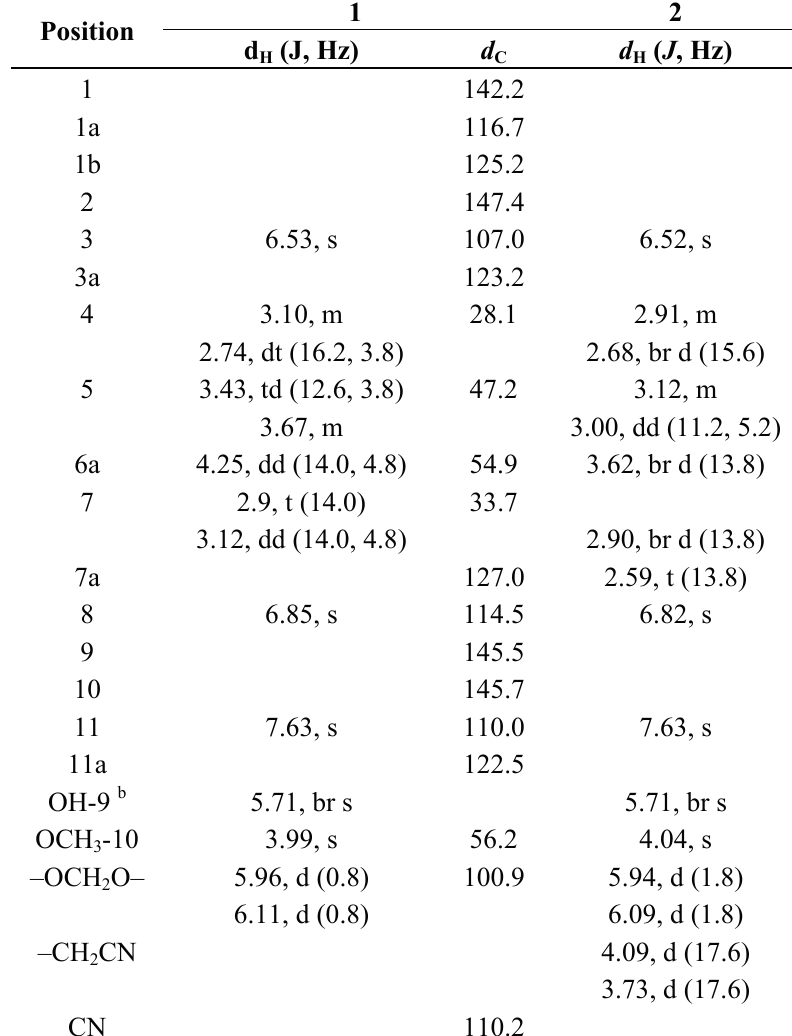
Table 1. 1 H and 13 C NMR data of compounds 1 and 2 a